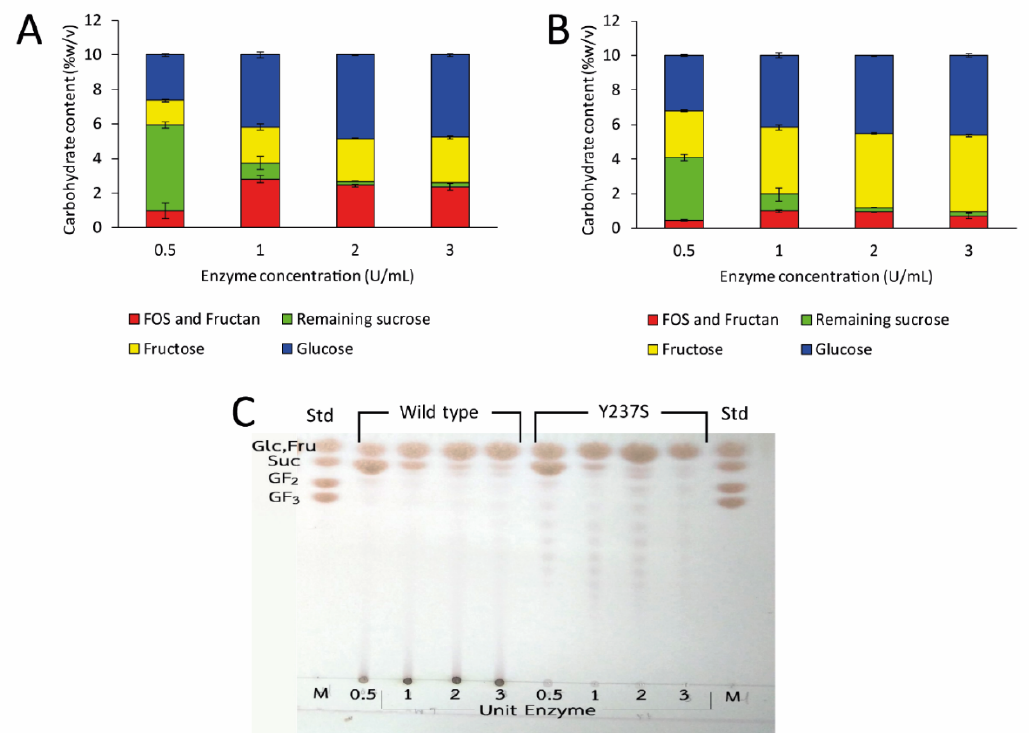
Figure 7. E ff ect of enzyme concentration on LFOS product. The amount of fructose, glucose, remaining sucrose and transglycosylated products produced by ( A ) wild-type and ( B ) Y237S variant LsKK9 was analyzed by HPLC. ( C ) LFOS profiles were analyzed by